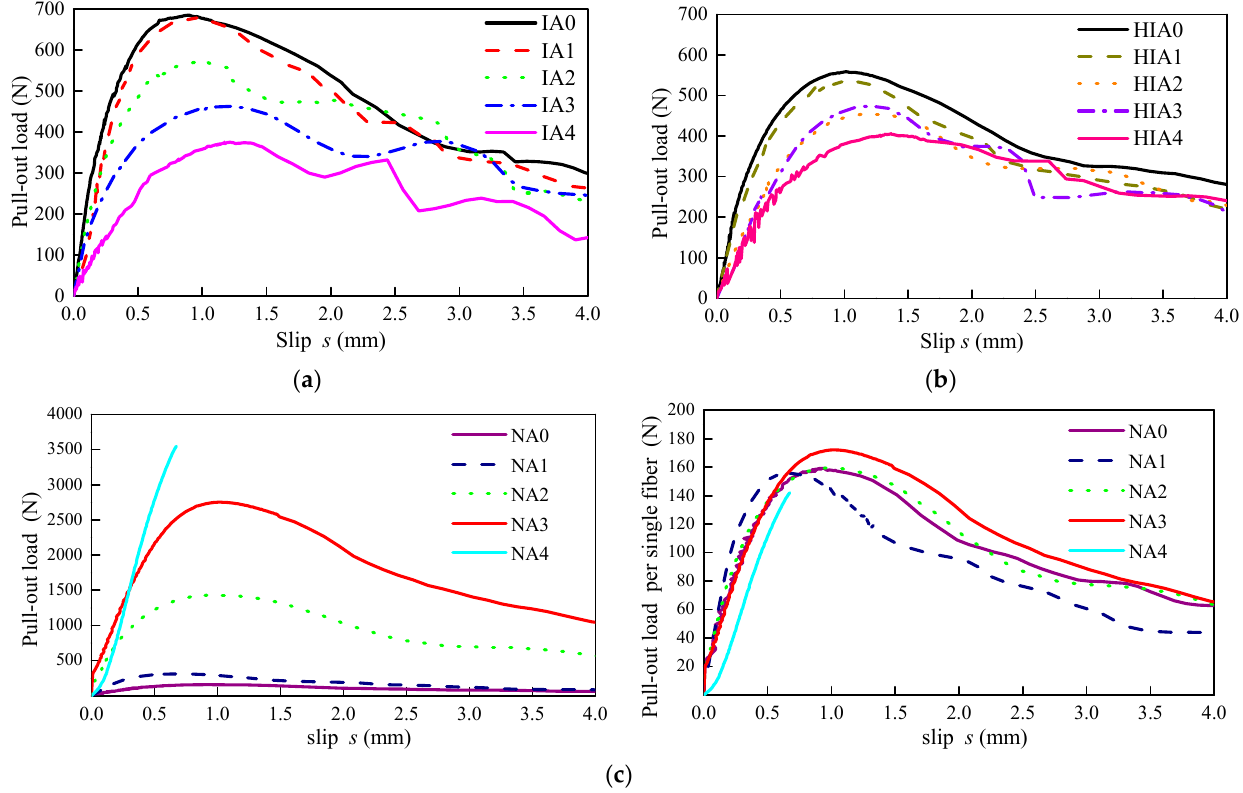
Figure 6. The characteristic PL-S curves. ( a ) Series IA, ( b ) Series HIA and ( c ) Series NA. Table 3. Test values at key points of the characteristic PL-S curves. Trials